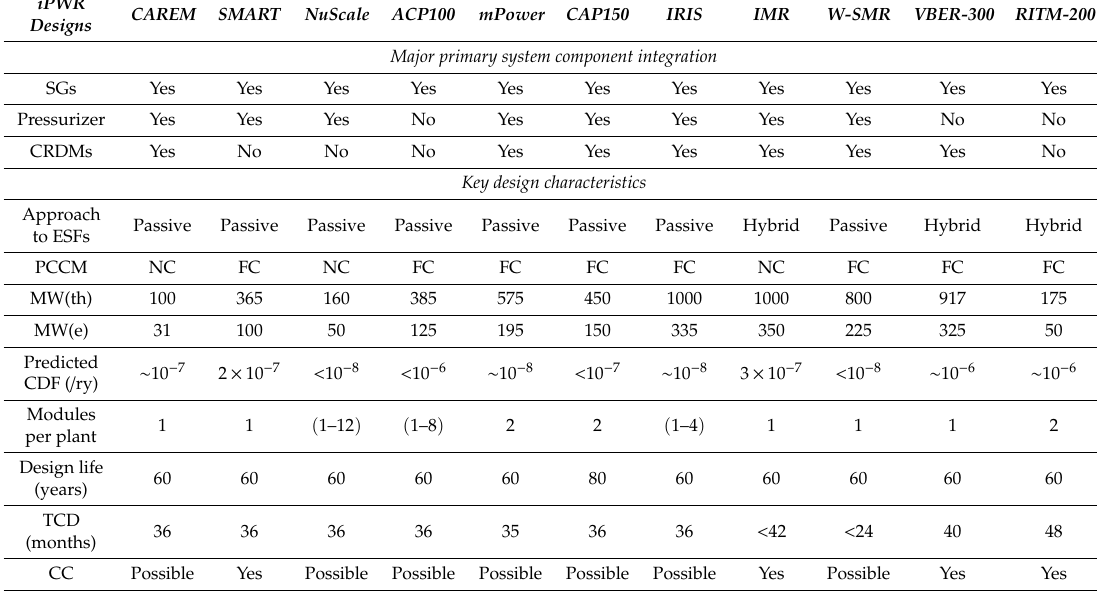
Table 2. Design characteristics of iPWR-type SMRs [18]. Reproduced from [18], IAEA: 2018. iPWR